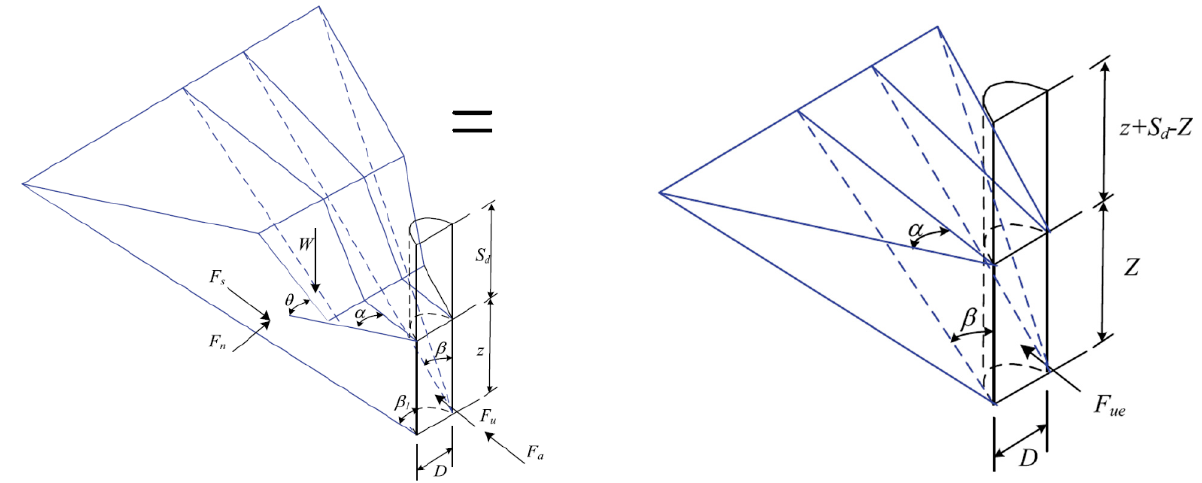
Figure 2. Wedge failure zone with and without a scour hole for laterally loaded pile [11].